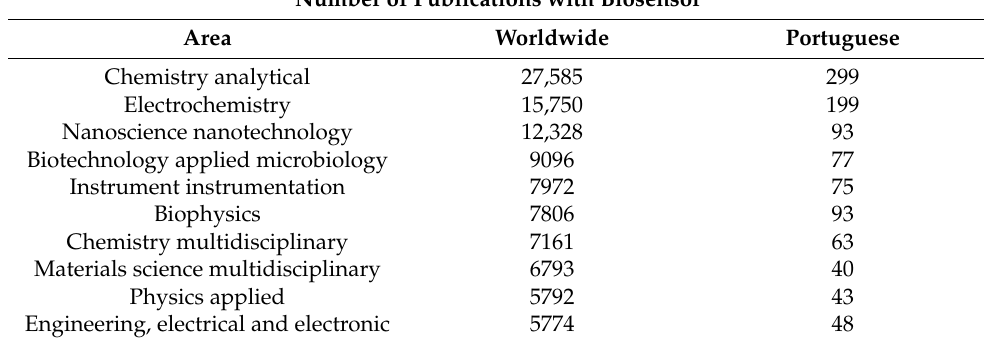
Table 1. Quantitative comparison between Portuguese (630 records) and worldwide research (68,680 records) on the distribution of publications in biosensors among the specified areas. Data obtained from webofknowledge.com cross-searching keywords: ALL FIELDS: (biosensor) and AD- DRESS: (Portugal), and only keyword: ALL Fields: (Biosensor) in Web of Science [v.5.34]—Web of Science Core Collection Result Analysis (webofknowledge.com). Number of Publications with Biosensor Area Worldwide Portuguese Chemistry